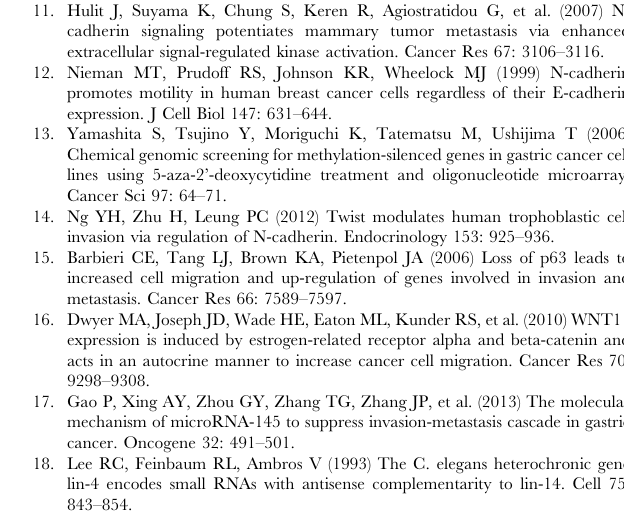
(TIF) Figure S2 Relative expression levels of miR-218 in lung cancer cell lines. A549, H1299, CL1-0, F4, and BM7 were described in Materials and Methods. Immortalized normal lung epithelial cells (HBEC-3KT) were kindly provided by Dr. John D (TIF) Figure S3 Over-expression of miR-218 suppressed the expression of CDH2 . (A) Relative expression levels of miR-218 in H1299 cells over-expressing miR-218. The expression levels of miR-218 were detected using real-time PCR at 0 and 48 h after transfection. MiR-191 was used as an internal control. *, P , 0.05. (B) Relative expression levels of CDH2 in H1299 cells over- expressing miR-218. 18S rRNA was used as a loading control. *, P , 0.05. (C) Western blot analysis of CDH2 in H1299 cells over- expressing miR-218. EF1A was used as an internal control. (TIF) Figure S4 Over-expression of miR-218 using a tetracy- cline-inducible construct. (A) Relative expression levels of miR-218 in BM7 cells treated with different doses of tetracycline. Tet: tetracycline; Pool: pool population; Clone 2: a selected stable clone. (B) Western blot analysis of CDH2 in tetracycline-induced BM7 cells overexpressing miR-218. EF1A: EF1 a .